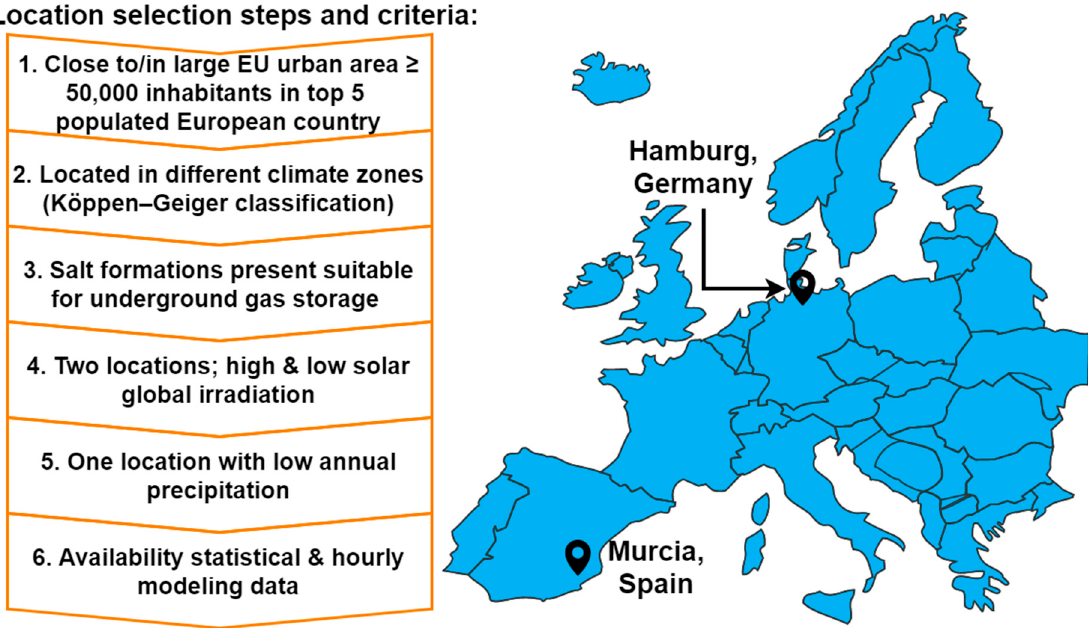
Figure 1. Location selection steps and criteria resulted in the urban area of Hamburg in Germany and Murcia in Spain.